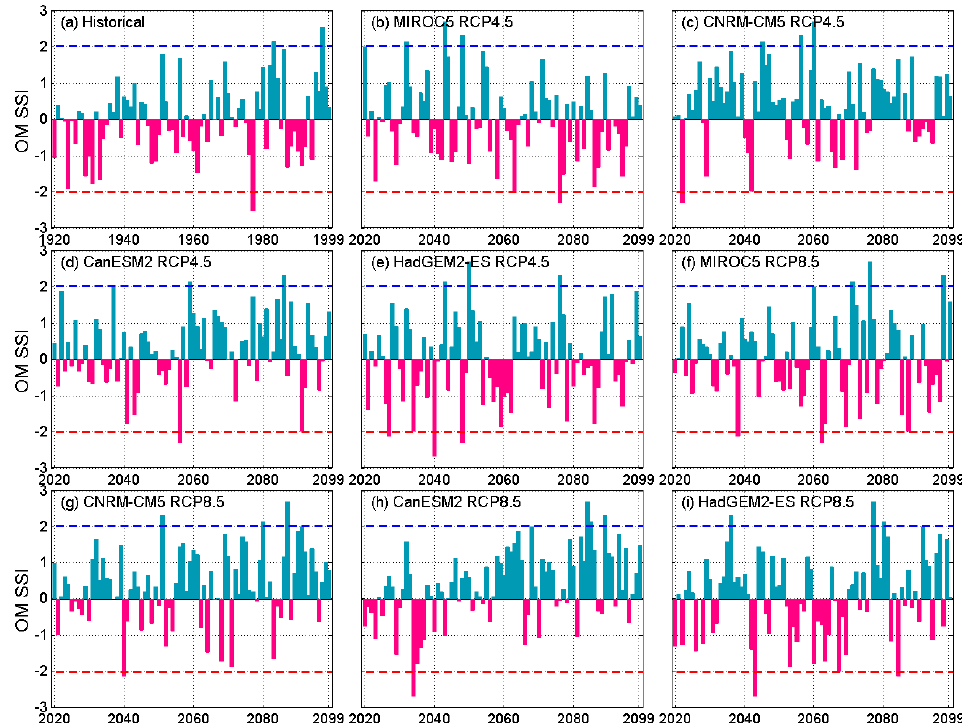
Figure A5. Historical and projected October–March SSI for SJQ4. Values above the blue dash line represent extremely wet conditions while values below the red dash line indicate extremely dry conditions.